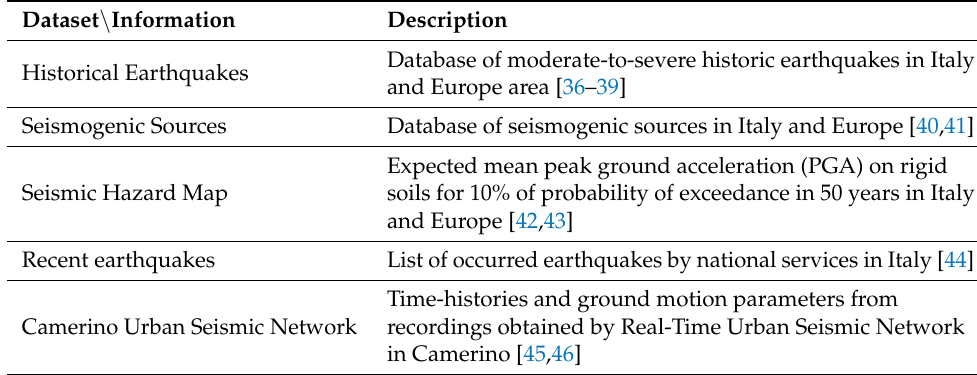
Table 5. Information contained in THIS and available for the DSS.